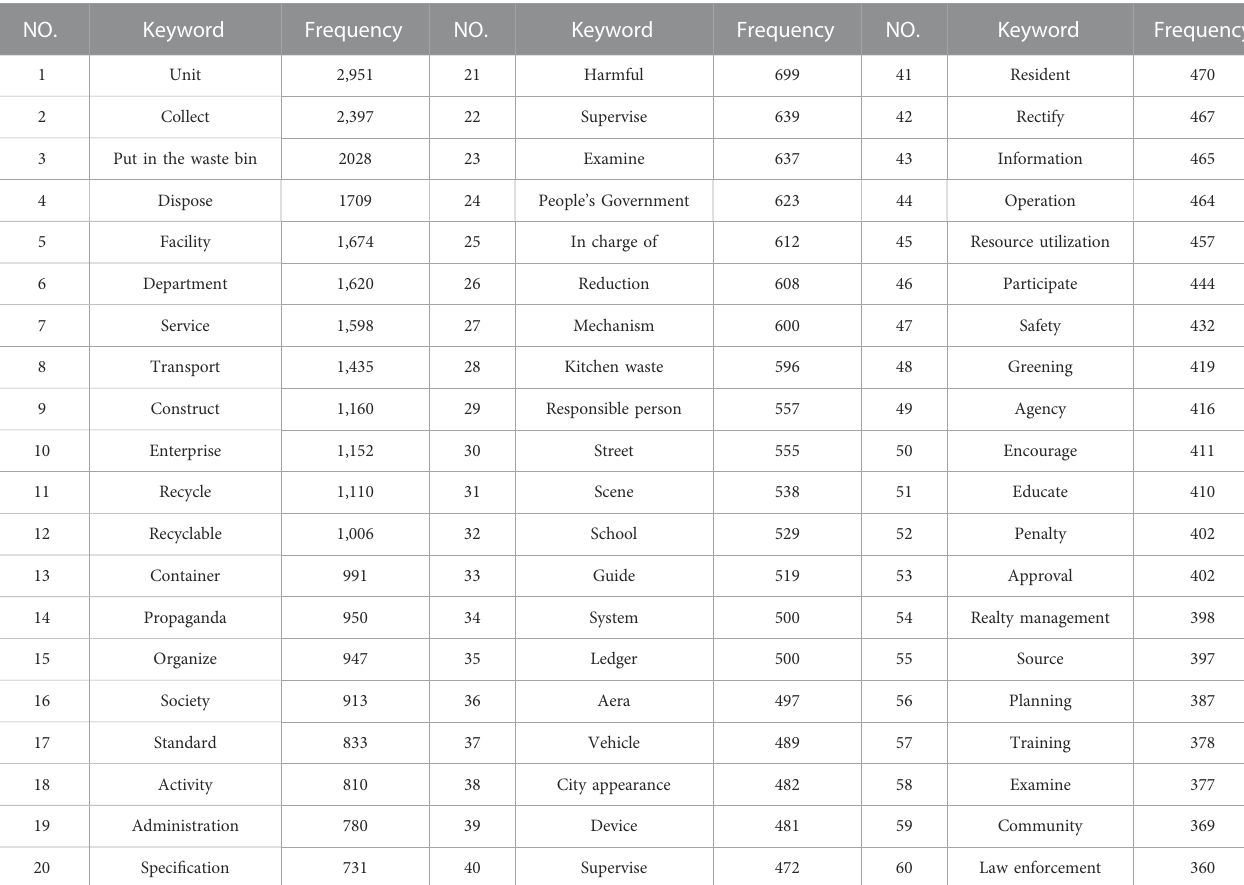
TABLE 1 High-frequency keywords statistics of China ’ s MSWSM